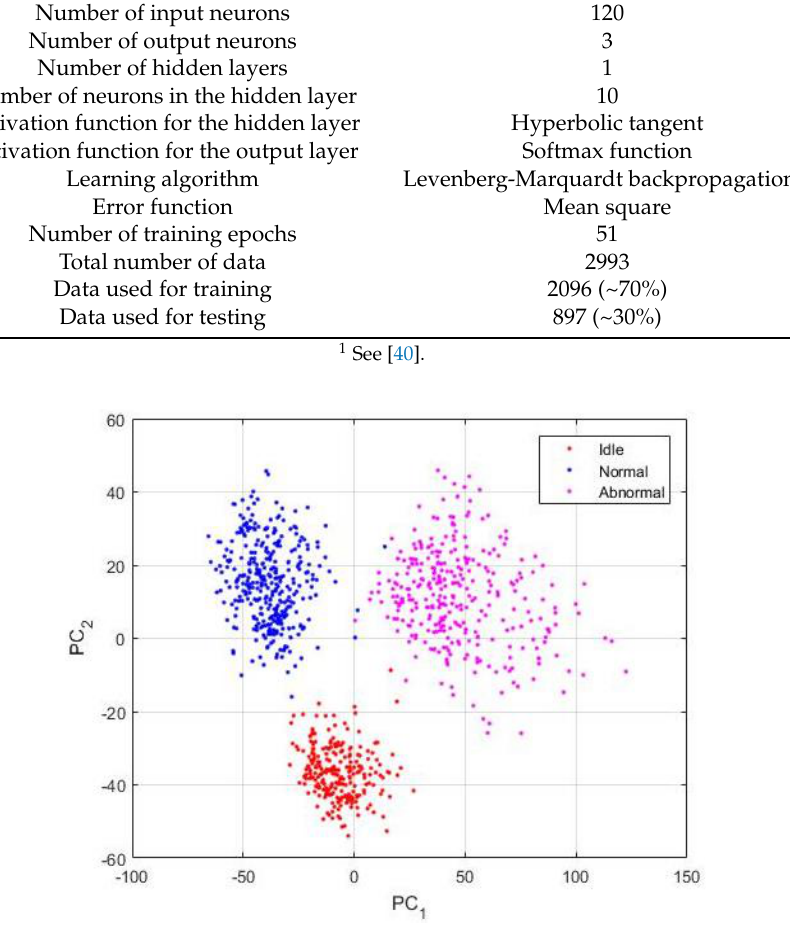
Figure 15. Visualization of the PSD-images + DCAE features of the 897 testing data.